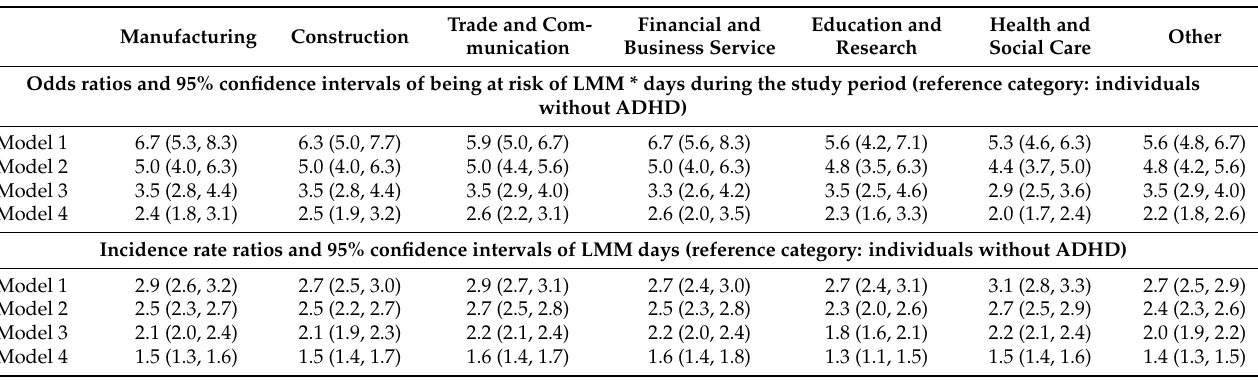
Table 2. Labor market marginalization (LMM) by occupational branches among young employed individuals with and without attention deficit hyperactivity disorder